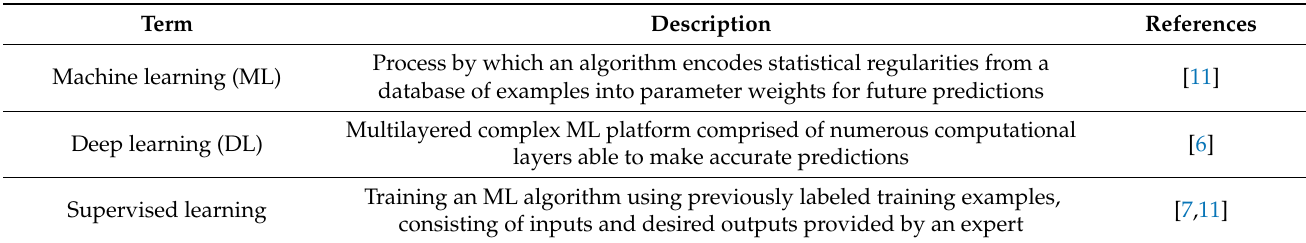
Figure 1. Relationship between AI, ML, and DL. Created based on information from [4,8–10]. Table 1. Important AI-related terms and definitions.